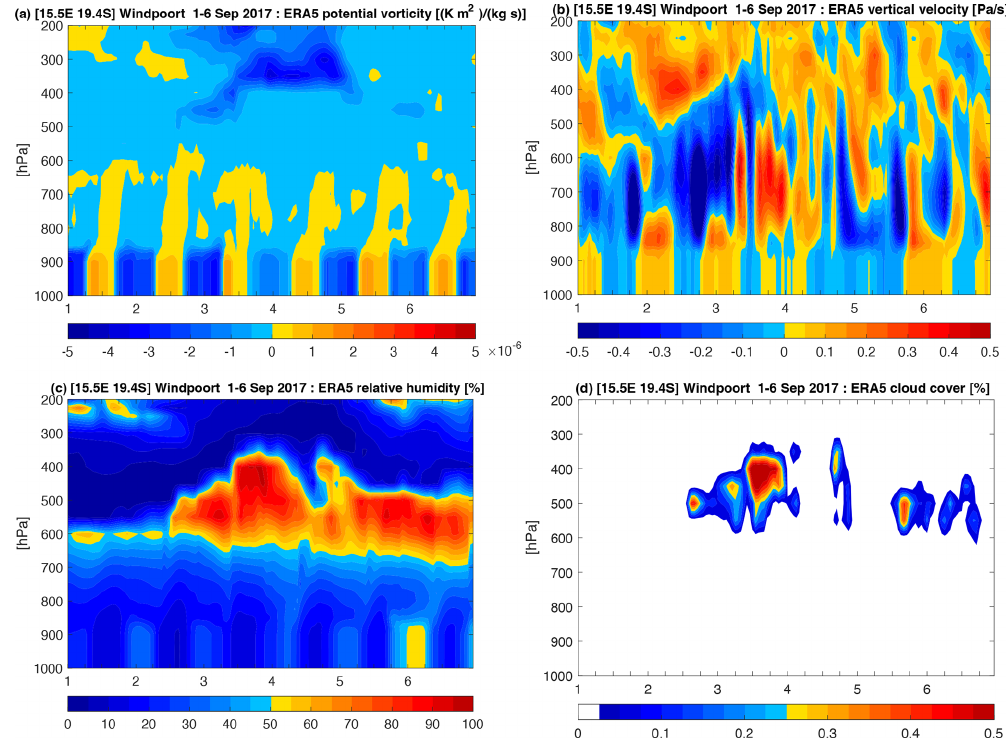
Figure 13. Time–height cross section of (a) potential vorticity (Km 2 kg − 1 ,s − 1 ), (b) vertical velocity (Pas − 1 ), (c) relative humidity (%) and (d) cloud cover over Windpoort between 1 and 6 September 2017 from hourly ERA5 reanalysis. Ascending motions are associated with negative ω